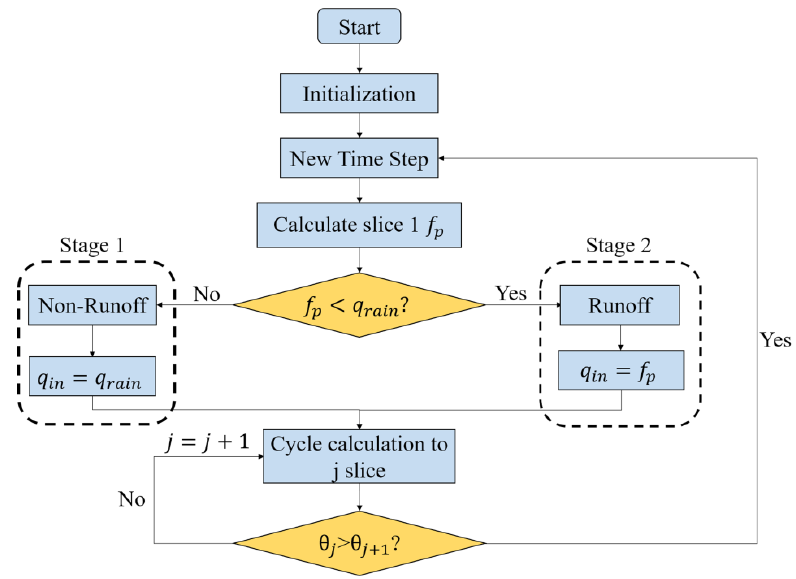
Table 1. The hydraulic parameters of the Brooks–Corey model. Figure 2. Flow chart of computational process. Figure 2. Flow chart of computational process.